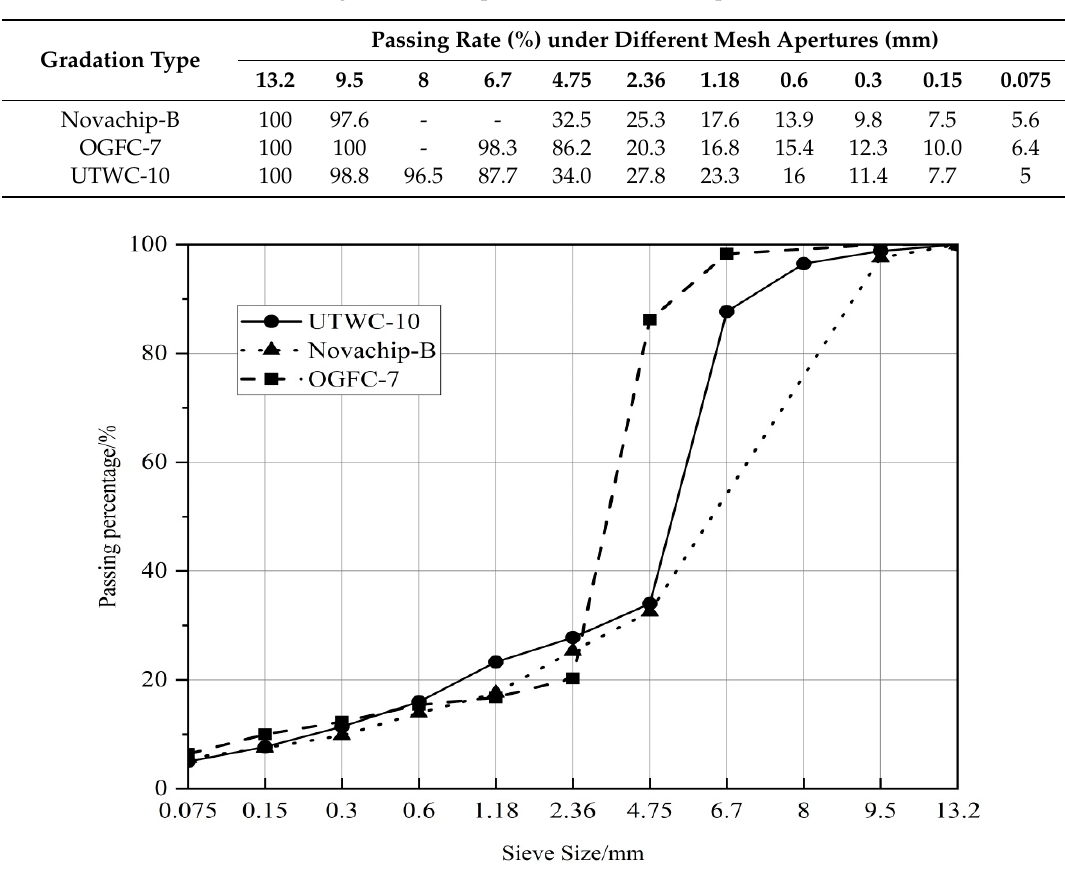
Figure 3. The gradation curves of the three asphalt mixtures.